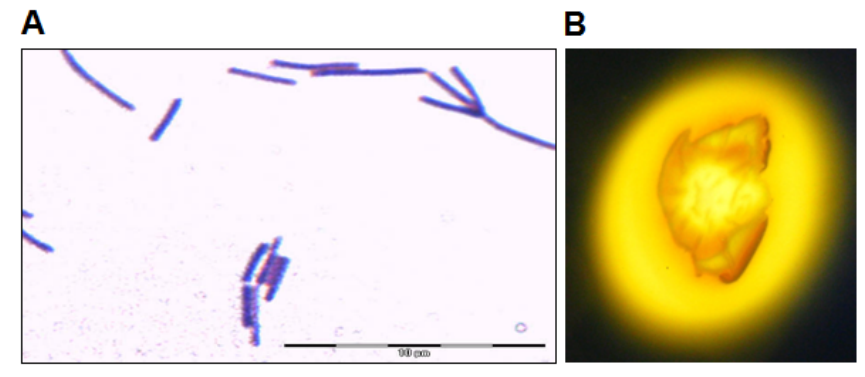
Figure 1. Morphology and amylolytic activity of L62. ( A ) Cell morphology of L62 (at 1,000× magnification using light microscope). Bar represents 10 µm. ( B ) Amylolytic activity of strain L62, as indicated by the halo formation surrounding the bacterial